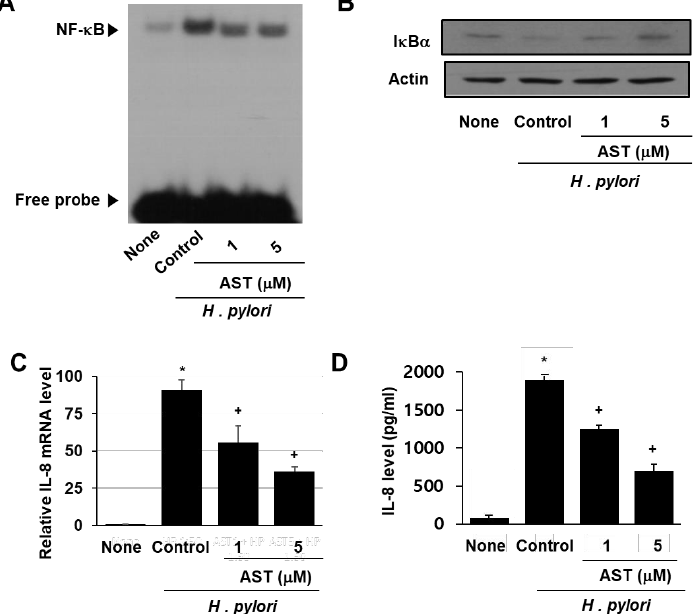
Figure 2. Effect of astaxanthin on NF- κ B activation and I κ B α and IL-8 levels in H. pylori -infected AGS cells. The AGS cells were pre-treated with the indicated concentrations of astaxanthin for 3 h and then stimulated with H. pylori for 1 h (for NF-kB activation, I κ B α level), 4 h (for IL-8 mRNA level), and 24 h (for IL-8 protein level in the medium). ( A ) Audioradiogram of the EMSA gel on which nuclear extracts treated with a [ 32 P]-oligonucleotide NF- κ B probe were chromatographed. Column “None” corresponds to the uninfected AGS cell extract, column “Control” to the H. pylori –infected AGS cell extract, and columns “1” and “5”to the extracts of H. pylori –infected AGS cells pre-treated with 1 and 5 µ M astaxanthin, respectively. ( B ) Western blot analysis of I κ B α (and the protein standard actin) present in uninfected cells (column “None”), H. pylori –infected cells (column “Control”), and H. pylori –infected cells pre-treated with 1 and 5 µ M astaxanthin, respectively (columns “1” and “5”). ( C ) Plot of the relative amounts of IL-8 mRNA present in uninfected AGS cells (column “None”), H. pylori –infected AGS cells (column “Control”), and H. pylori –infected cells pre-treated with 1 and 5 µ M astaxanthin, respectively (columns “1” and “5”). ( D ) Plot of the concentration of the protein IL-8